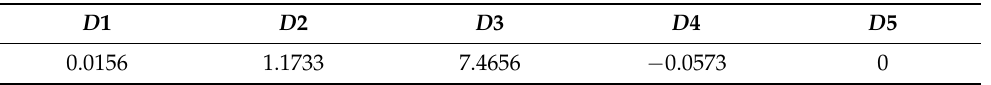
Table A1. Johnson–Cook damage model parameters for SBPR 930/1080 Type B No. 1 based on fracture point estimation.